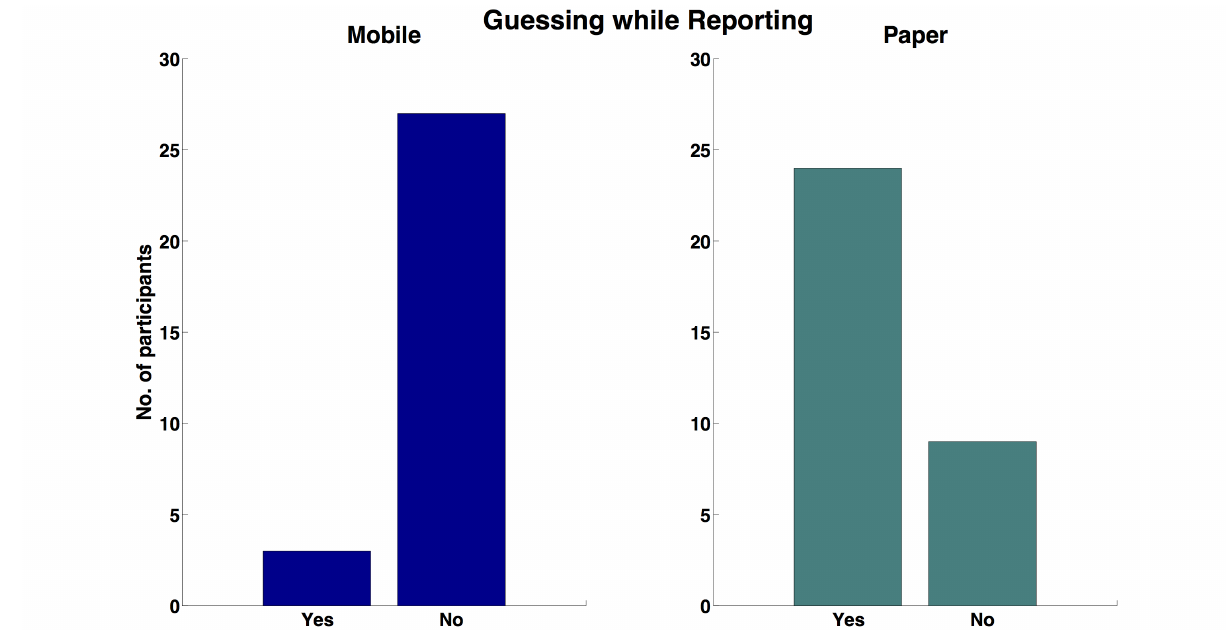
Figure 6. Frequency of guessing during activity compliance